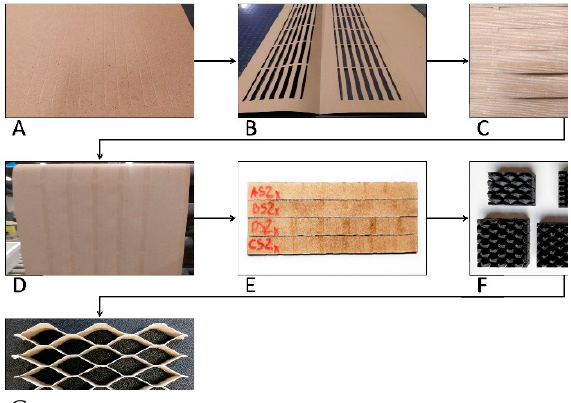
Figure 2. The process of manufacturing the core from sheets of paper: ( A ) burnishing of adhesive lines, ( B ) template for adhesive application, ( C ) folding of template and sheet of paper, ( D ) paper after adhesive application, ( E ) stacked and bonded strips of paper, ( F ) templates for stretching cell, ( G ) core cells after stretching.